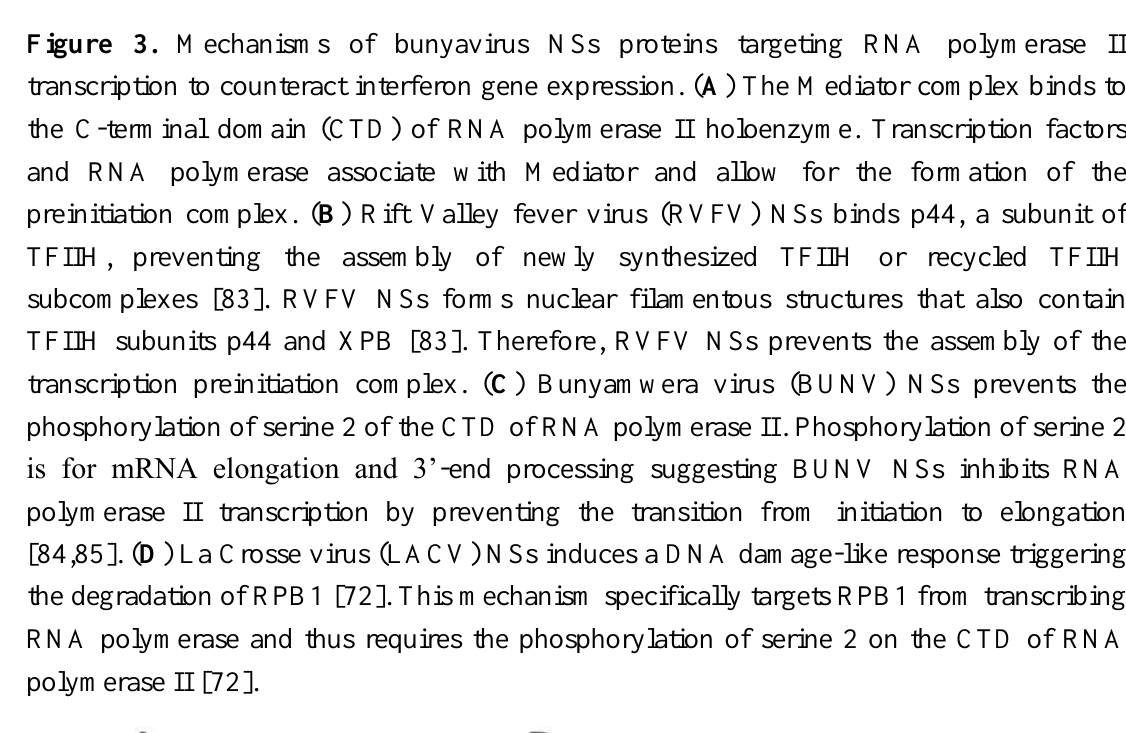
Figure 3. Mechanisms of bunyavirus NSs proteins targeting RNA polymerase II transcription to counteract interferon gene expression. ( A ) The Mediator complex binds